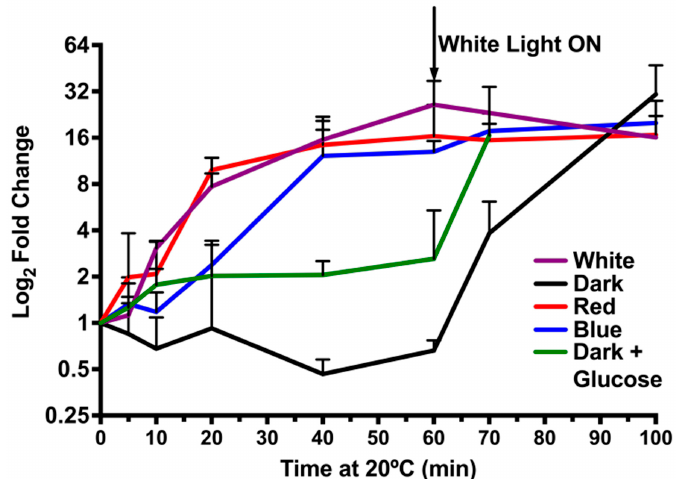
Figure 7. Reduction of the ETC is required for crhR transcript accumulation. Wild type Synecho- cystis cells were grown to mid-log phase at 30 °C and the effect of varying light quality on crhR transcript accumulation was analyzed in conjunction with temperature downshift. Aliquots were transferred to 20 °C at T = 0 in the absence (black line) or presence of glucose (green line) in the dark, or with continued illumination with white light (purple line), blue light (blue line) or red light (red line) for 60 min. At 60 min, all cultures were subsequently transferred to white light for an additional 40 min. crhR transcript levels were determined by qPCR and normalized to basal levels at 30 °C in white light. The data was obtained from two biological replicates. Error bars represent standard deviation.